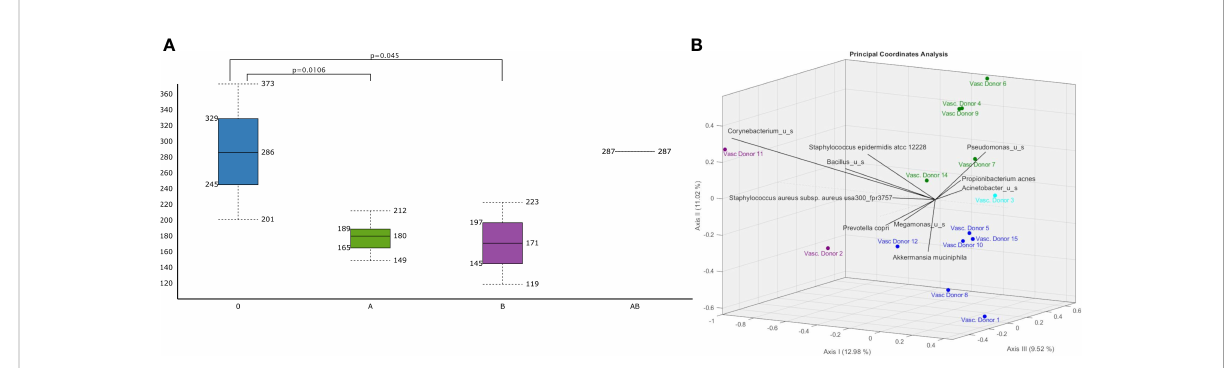
FIGURE 4 Differences in vascular microbiomic diversity according to A (green)/B(purple)/AB(light blue)/O(dark blue) blood groups. (A) Chao1 Alpha Diversity of human vascular microbiome signi fi cant differences are indicated with p values and (B) bi-plot Jaccard Beta Diversity Principal Coordinate Analysis according to A/B/AB/O blood